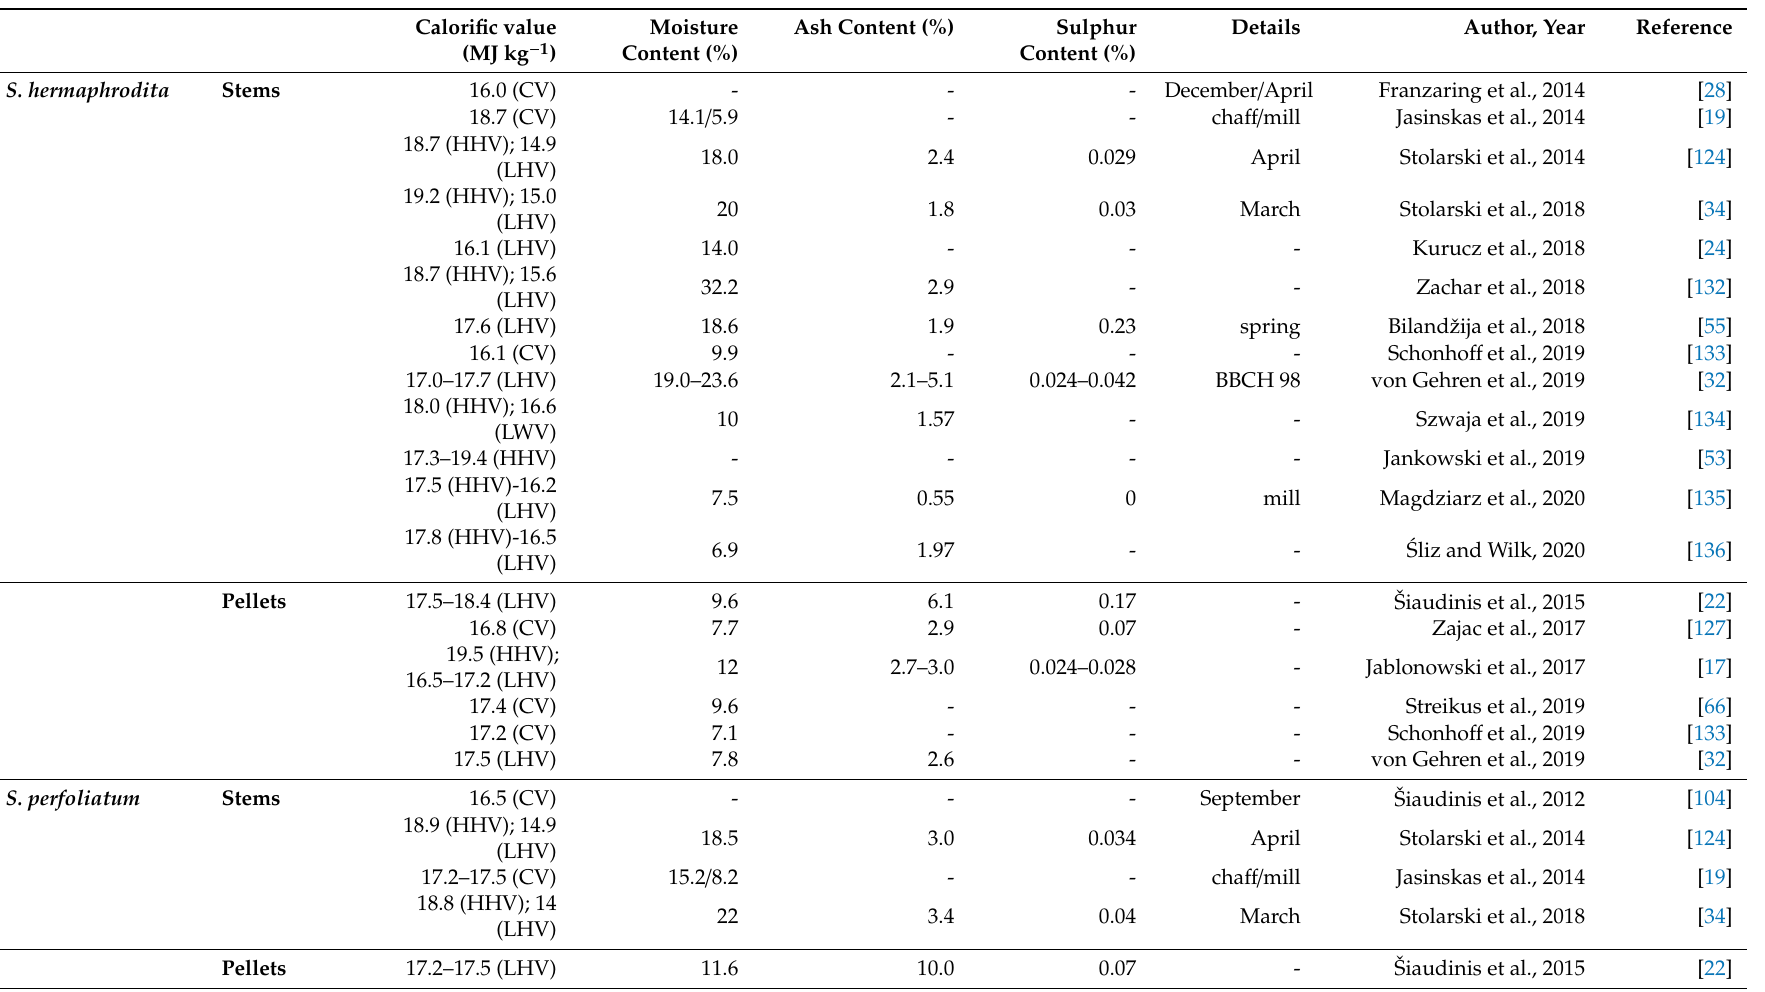
Table 6. Reported calorific value, and moisture, ash, and sulphur content of S. hermaphrodita and S. perfoliatum for biomass